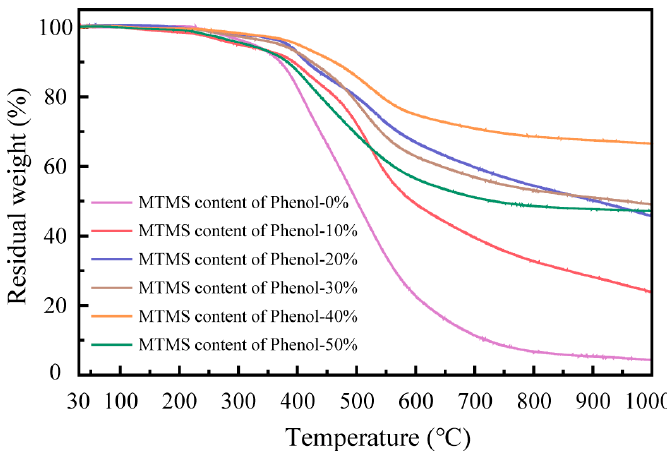
Figure 8. TGA of phenolic resin modified with different content of MTMS at 30~1000 °C.